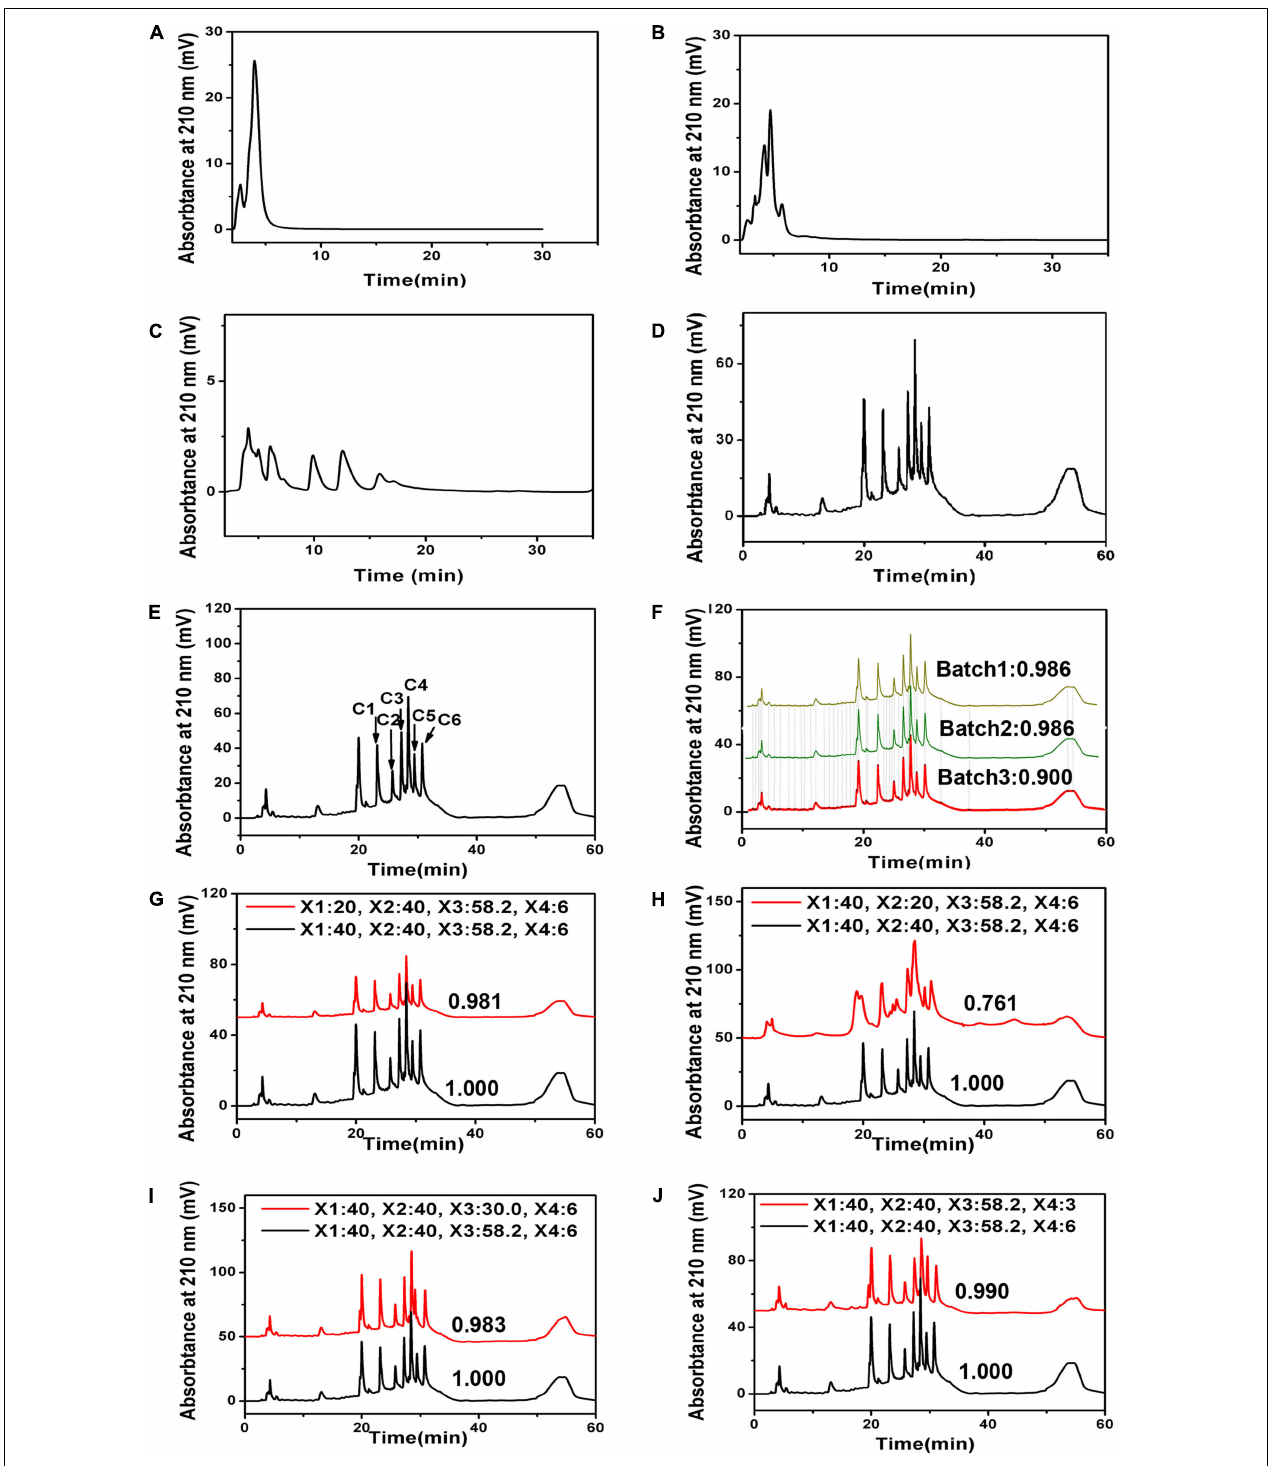
FIGURE 4 | Similarity evaluation system of traditional Chinese medicine chromatographic fingerprinting (SES-TCMCF) of ZNC. High-performance liquid chromatography (HPLC) of ZNC with different elution conditions. (A) 30% methanol, (B) 60% methanol, (C) 90% methanol, (D) 95% methanol for 5 min followed by linear gradients from 95 to 90% methanol from 5 to 10 min, from 90 to 60% methanol over 10–20 min, and from 60 to 0% methanol over 20–28 min; finally, 0% methanol was maintained from 28 to 43 min, (E) characteristic peaks used for quantitative analysis of ZNC; (F) similarity and HPLC among different batches of ZNC using SES-TCMCF; (G–J) similarity and chromatograms for comparing extractions with different process parameters (red line) and extractions with optimal process parameters (batch1).